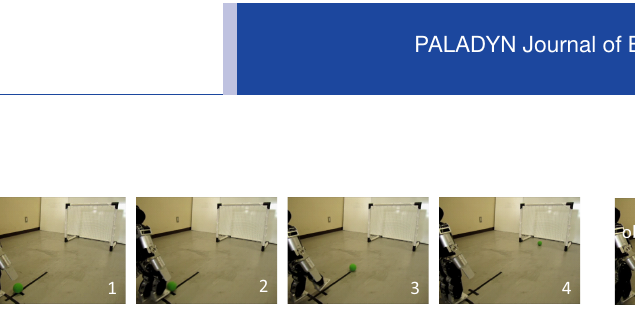
Figure 12. Experimental scenes of kicking motion in Environment 2 by the